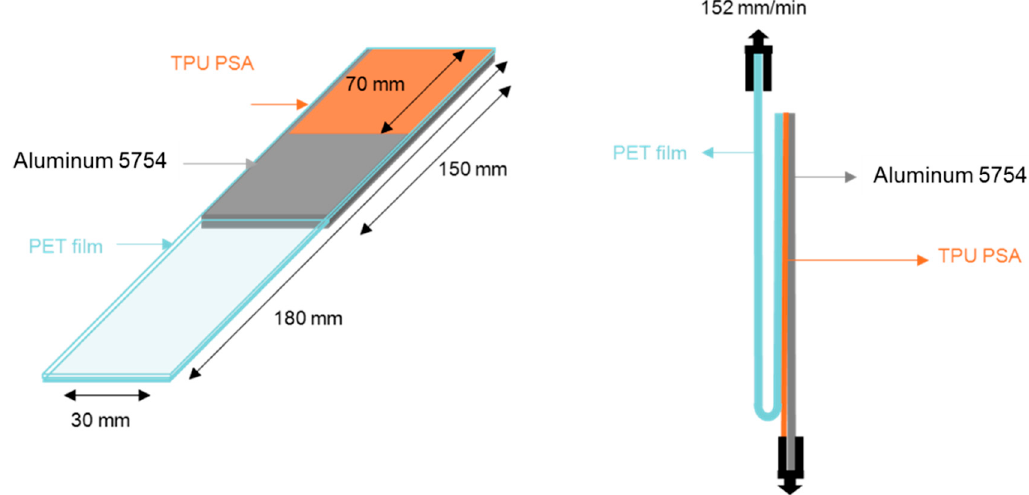
Figure 2. Scheme of the 180° peel test of aluminum 5754/TPU/polyethylene terephthalate (PET) joint.